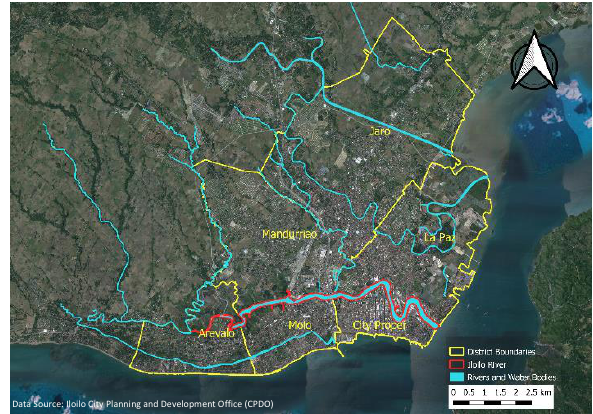
Figure 1. Map of the study site showing the administrative